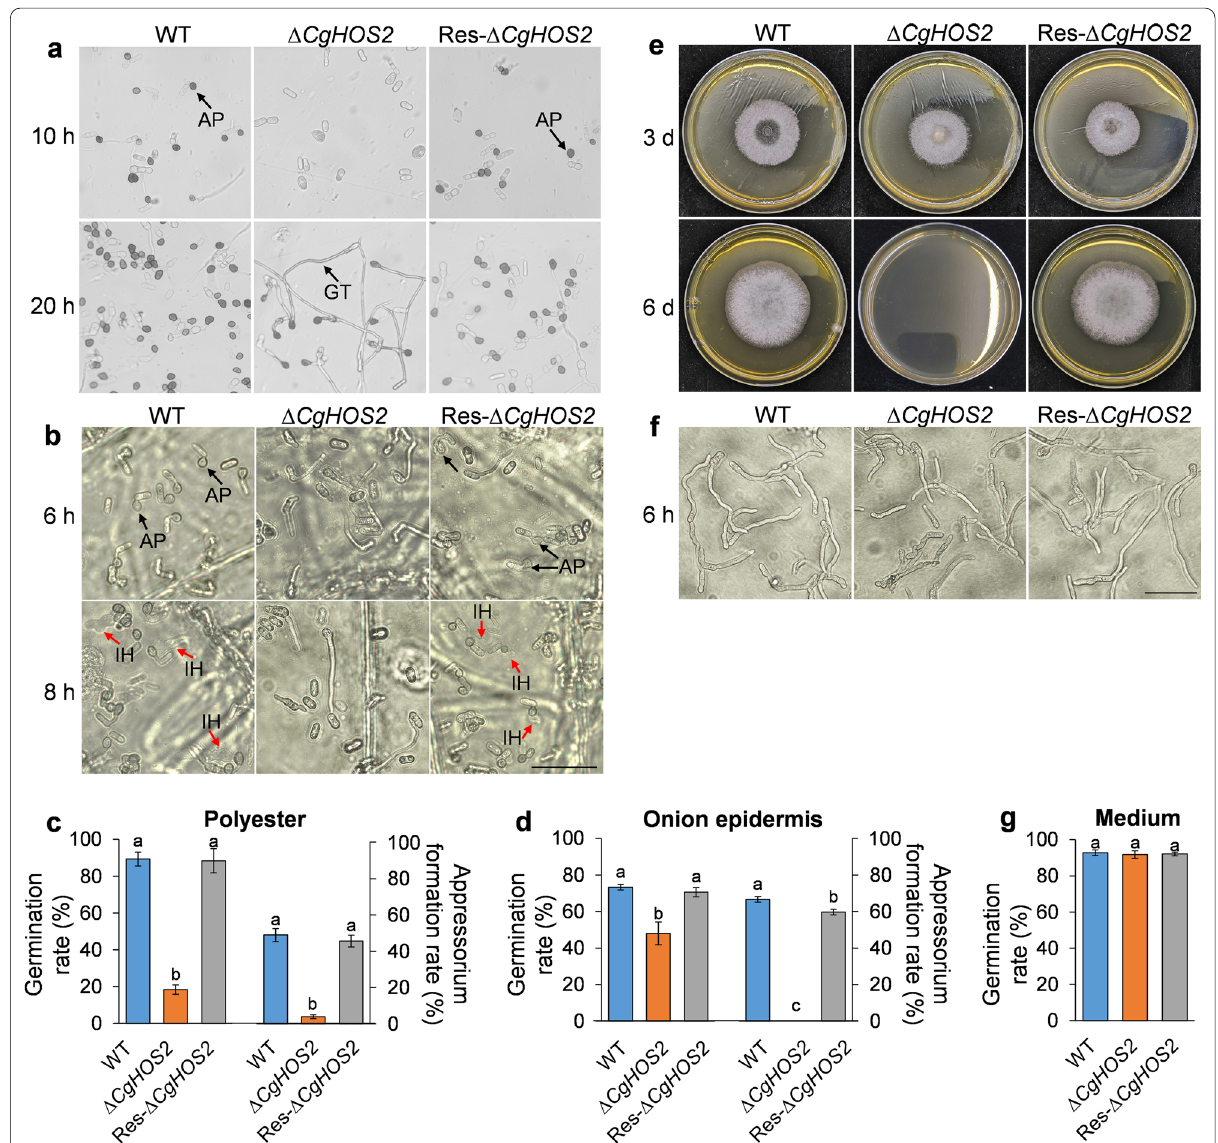
Fig. 6 CgHOS2 is required for normal appressorium formation and penetration. a Microscopy observations of conidia incubated on polyester for 10 and 20 h. The black arrows indicate appressoria (AP) and germ tubes (GT). Bar 50 μm. b Microscopy observations of conidia incubated on = onion epidermis for 6 and 8 h. The red arrows indicate invasive hyphae (IH). c Conidial germination and appressorium formation rates on polyester. d Conidial germination and appressorium formation rates on onion epidermis. e Colony morphology of fungi cultured on cellophane for 3 and 6 days. The cellophane membrane was removed after incubation for 3 days, followed by incubation for another 3 days. f Microscopy observations of conidia incubated on cellophane for 6 h. g Conidial germination rates on cellophane for 6 h. The values are shown as the means standard ± deviations (SD) of three groups of samples. The columns with different letters indicate significant differences ( P <